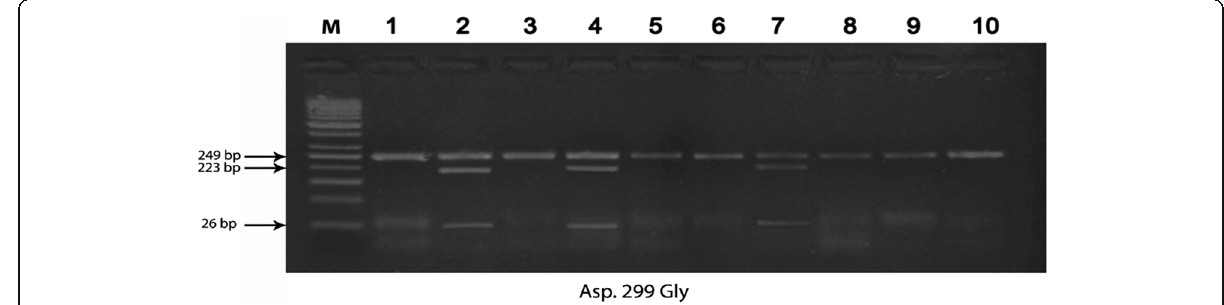
Fig. 1 Using RFLP restriction enzyme (NCOI-HF), the identified bands after transillumination by UV transilluminator. From left to right: Shows, M (DNA marker), DNA ladder (lane 1-10) in (50 bp ladder). Lanes (2, 4, 7) show heterozygous genotype (Asp/Gly). Lanes (1, 3, 5, 6, 8, 9, and 10) show a wild genotype